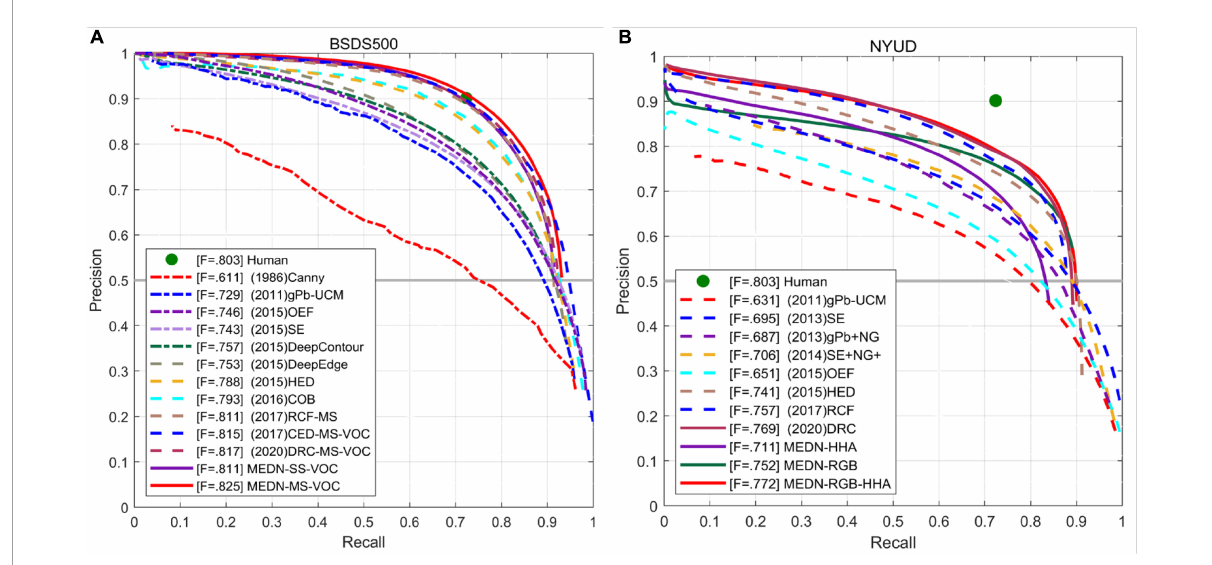
FIGURE8 PR curves of the proposed method and other methods on BSDS500 (A) and NYUD-v2 (B) data